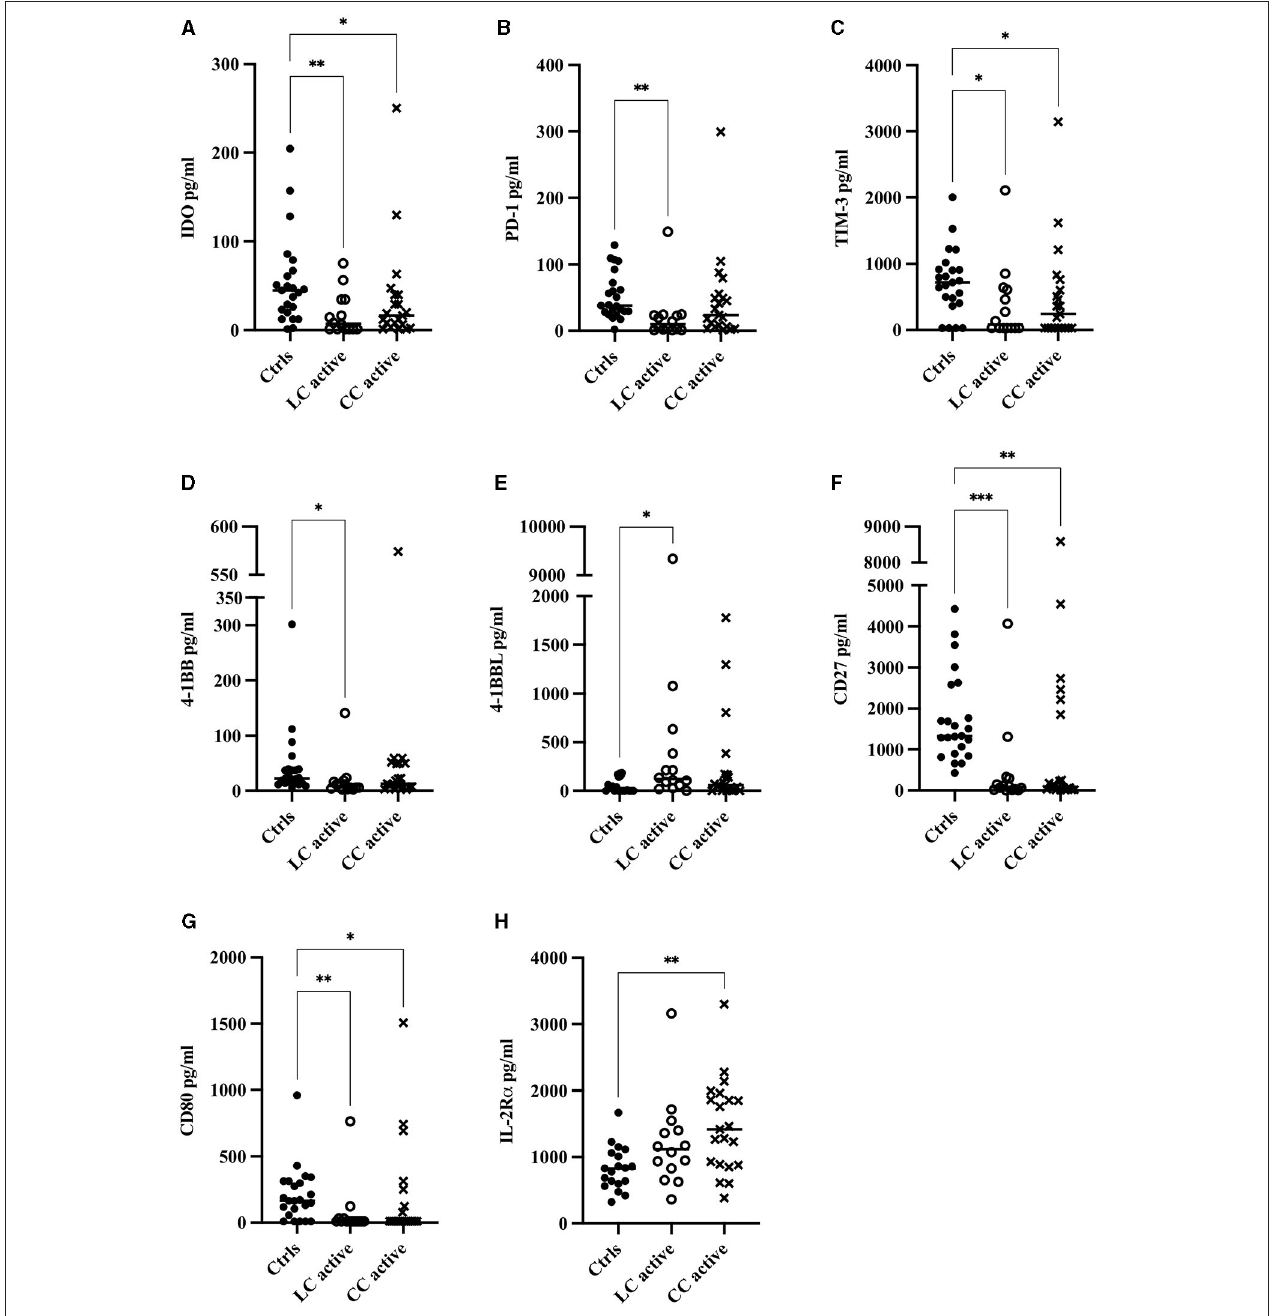
FIGURE 2 | Serum concentrations in pg/ml of all analytes that were significantly altered: (A) IDO, (B) PD-1, (C) TIM-3, (D) 4-1BB, (E) 4-1BBL, (F) CD27, (G) CD80, (H) IL-2R α in patients with active lymphocytic colitis (LC) or active collagenous colitis (CC) compared to controls. Each point represents one patient, and the median is shown as a horizontal line. Q -values obtained from performing the original false-discovery rate method of Benjamini–Hochberg are shown as * q < 0.05, ** q < 0.01, *** q <